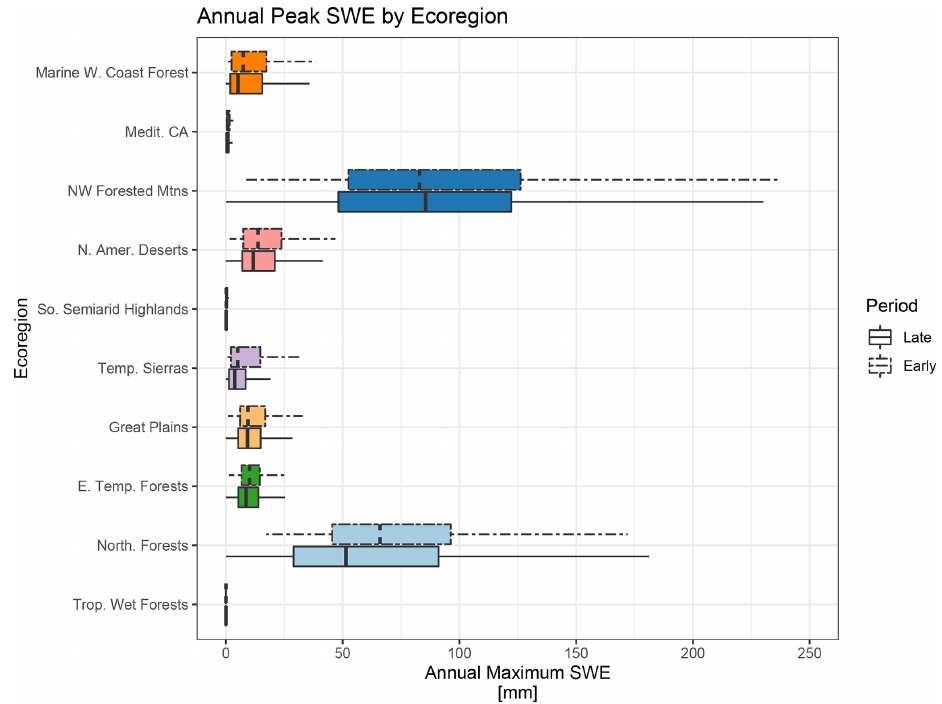
Figure B2. Box plot summarizing annual peak snow water equivalent (SWE) depths by ecoregion derived from the distribution of modeled estimates used in this paper. Box lower limits, midlines, and upper limits represent the 25th, 50th (median), and 75th percentiles, respectively, of the associated data. Whiskers represent 1.5 times the interquartile